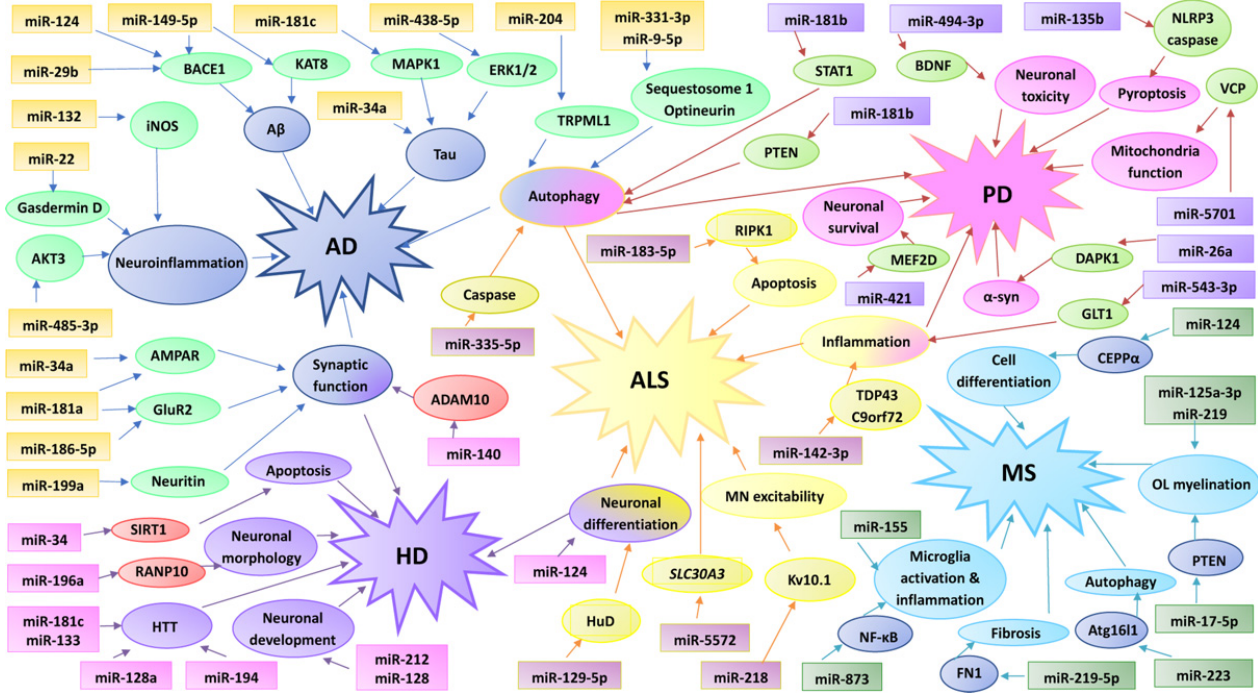
Figure 1. Complexity of the links between different miRNAs and molecular pathways–targets involved in neurodegenerative diseases.